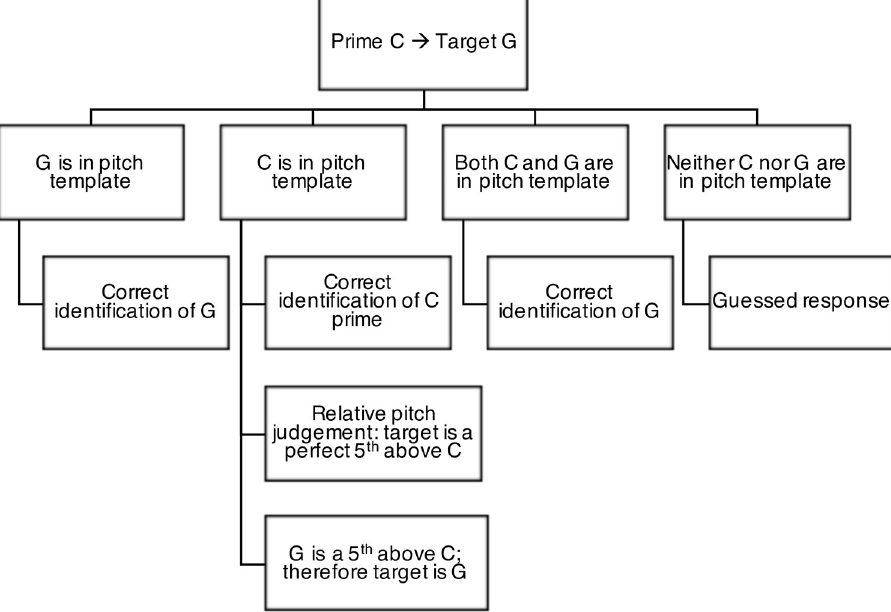
Fig 2. Decision tree for the explicit priming AP task (AP-P). The first line shows the presented stimuli–a C prime, followed by target G. The second line shows the hypothetical options for responding, given differing chroma in a participant’s pitch template. The third line shows the outcome from each possible scenario. Note that chance performance corresponds to 1/12, or 8.33%.